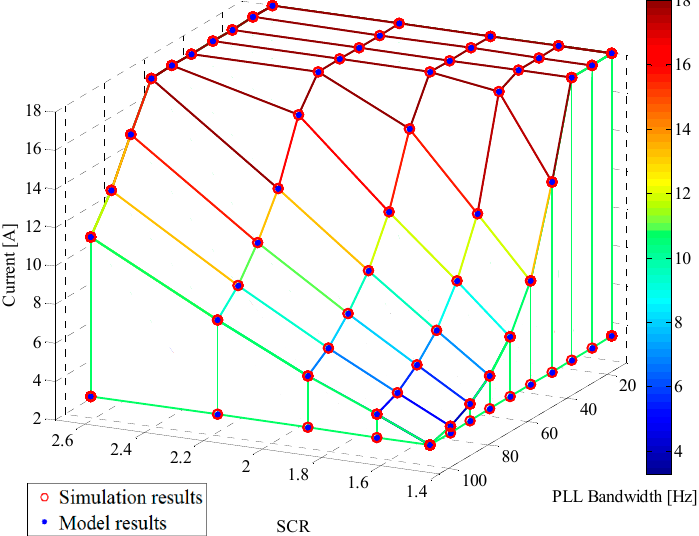
Figure 5. Maximum active current that the converter can be injected into the grid as a function of the PLL bandwidth and the SCR of the grid—Comparison between PLECs ® simulation and the proposed small signal model (nominal active current = 18 A).